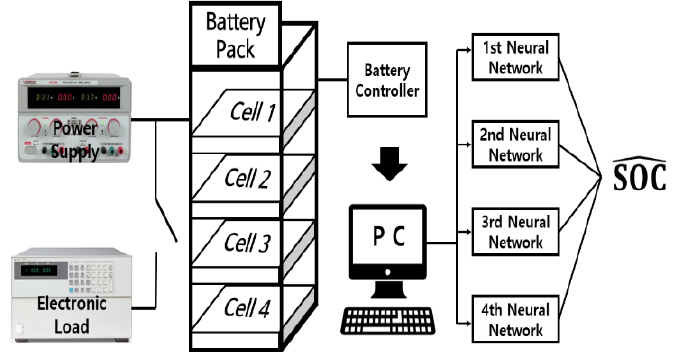
Figure 2. Schematic diagram of SOC estimation of each cell of the lithium battery pack.